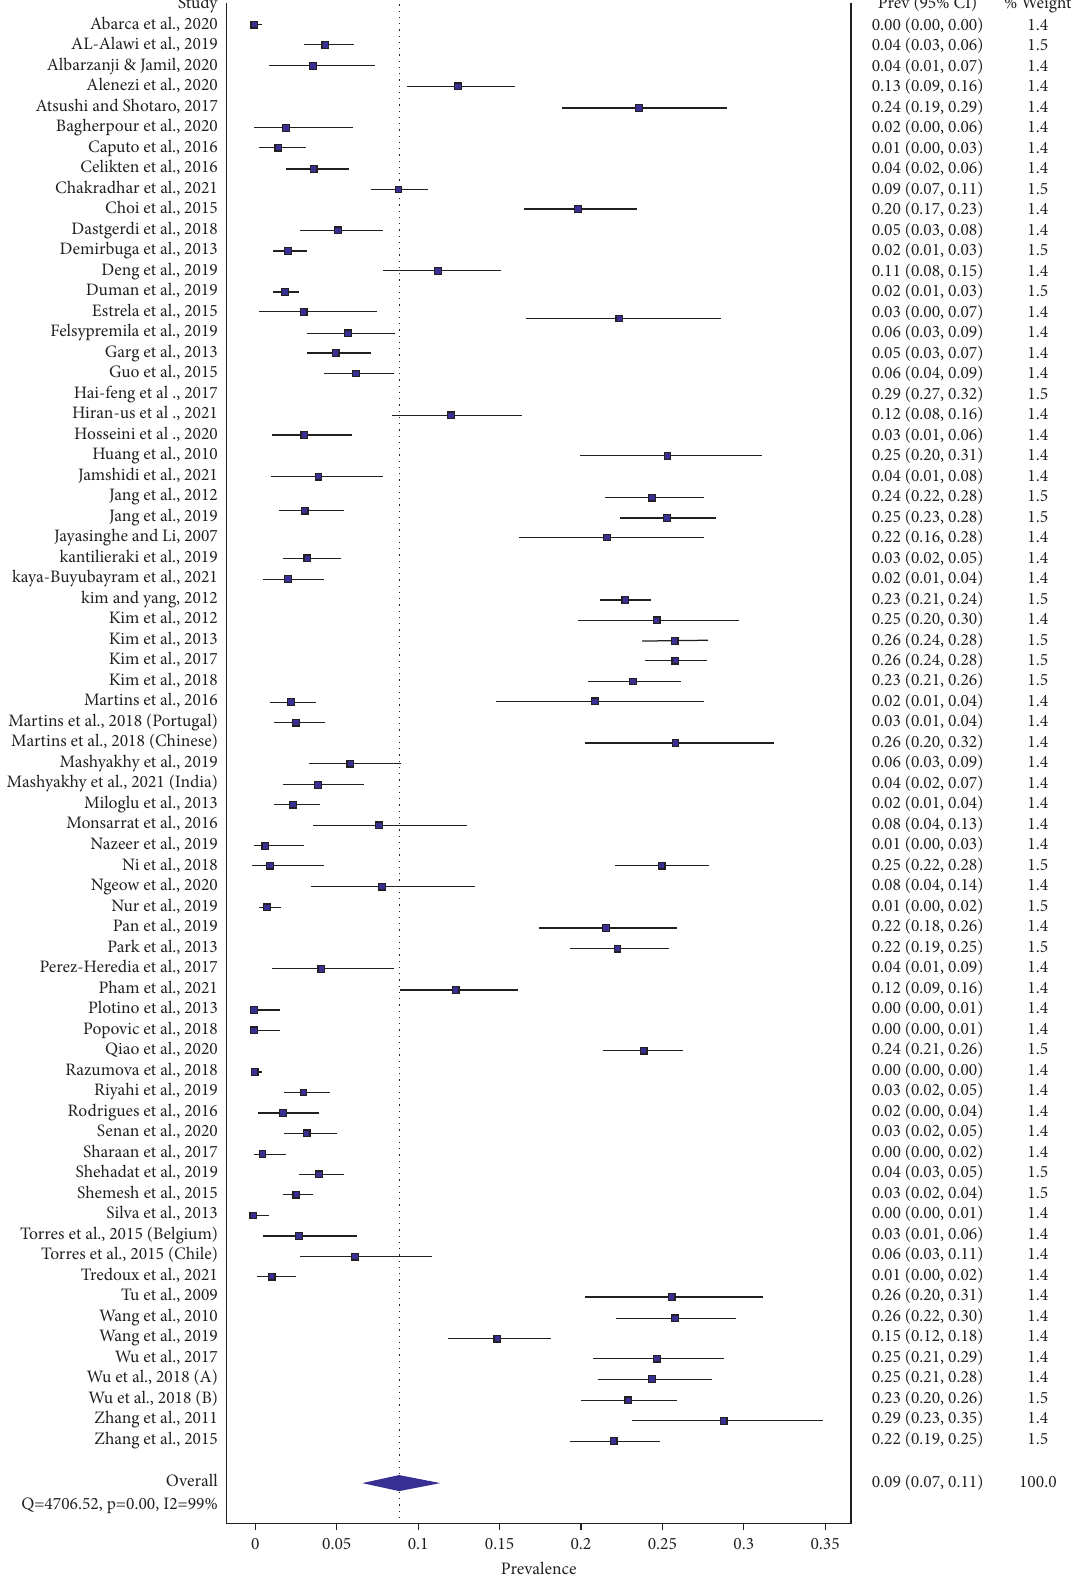
Figure 6: Global tooth-level prevalence of three-rooted